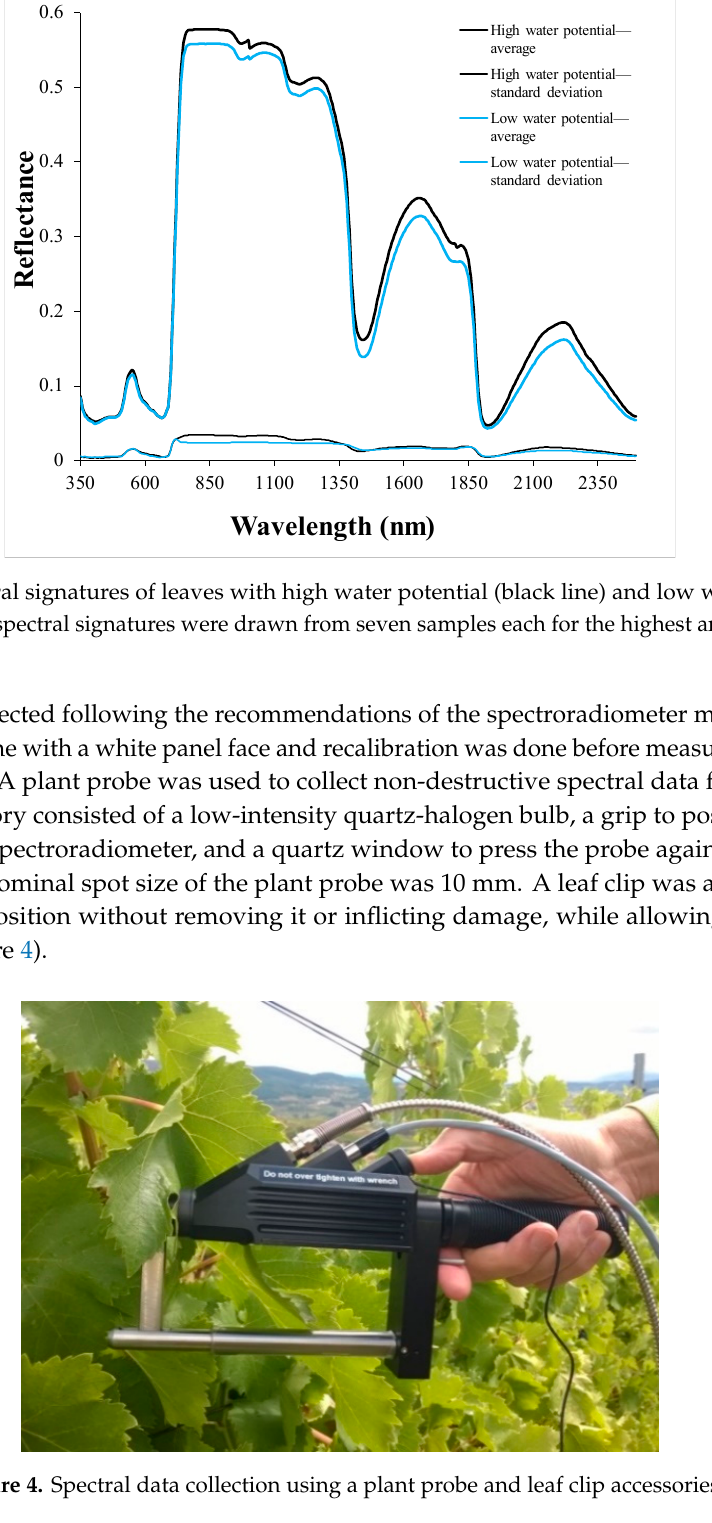
Figure 4. Spectral data collection using a plant probe and leaf clip accessories.